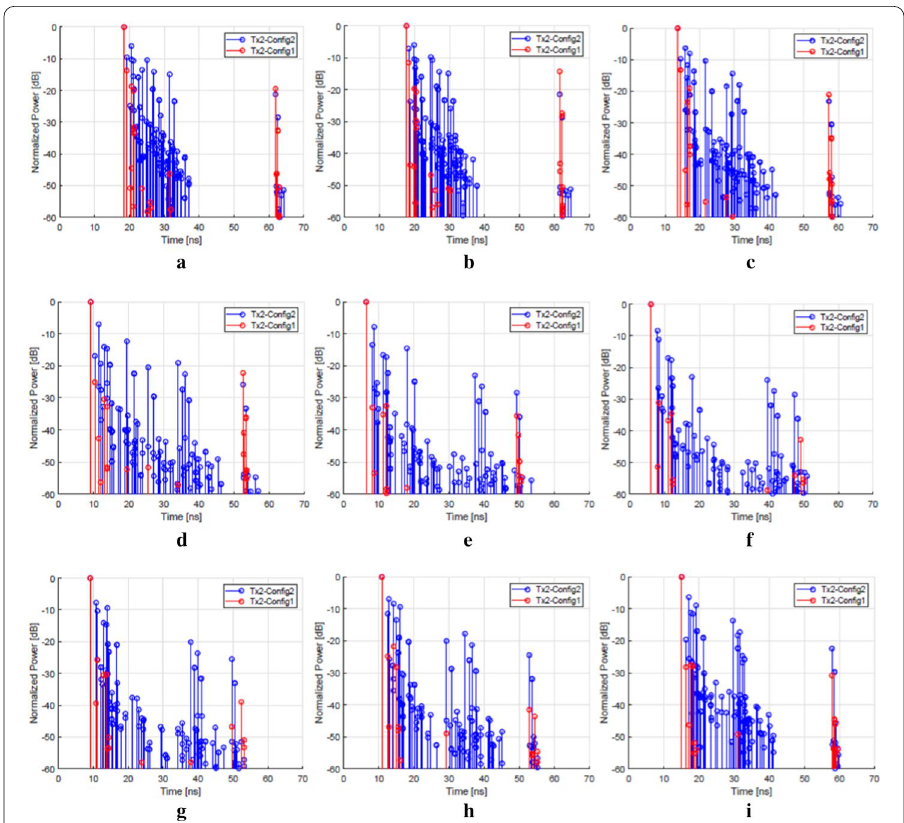
Fig. 15 Power delay profile with Tx2. a Pos 1, b Pos 2, c Pos 3, d Pos 4, e Pos 5, f Pos 6, g Pos 7, h Pos 8, and